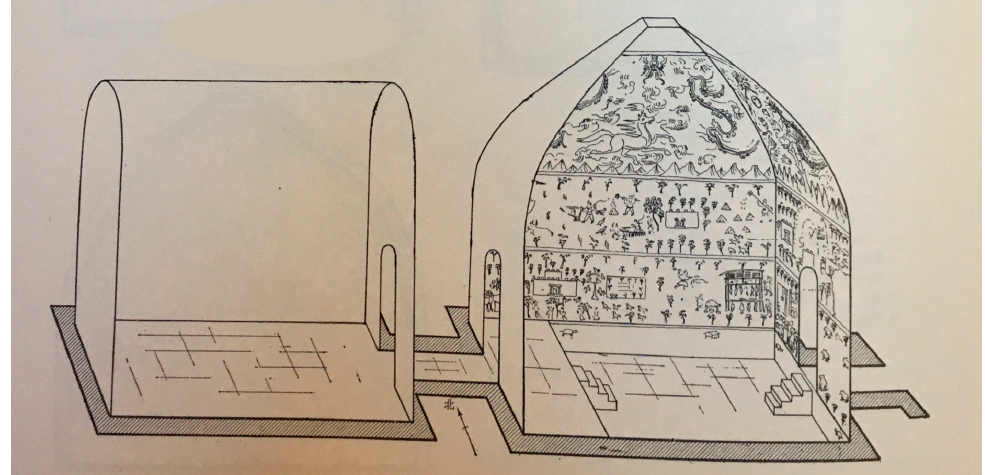
Figure 16. Schematic drawing of Dingjiazha M5 with view of north walls, Later Liang to Northern Liang dynasties (386–441). ( Jiuquan Shiliuguo Mu Bihua 1989, Figure 8). Liang dynasties (386–441). (Gansusheng Wenwu Kaogu Yanjiusuo 1989, Figure 8). ©Wenwu Press. This figure published with permission of Wenwu Press and cannot be used or copied without their